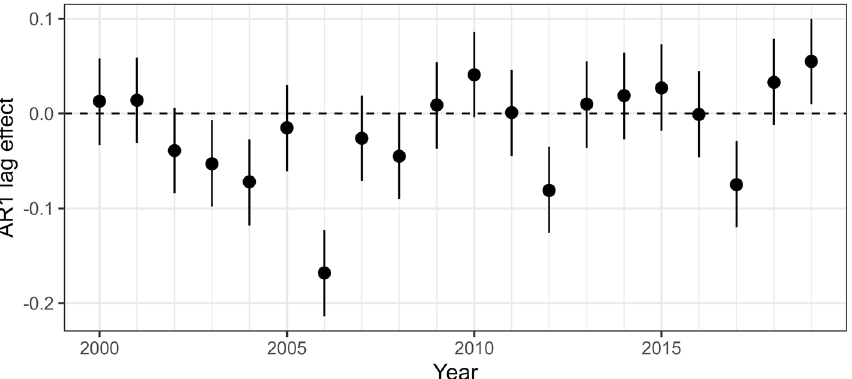
Figure 3. Log-scale median estimates with 95% credible interval of annual autocorrelation in point intensity (autoregressive, AR1 lag effect). The dashed line indicates a lag effect of 0.